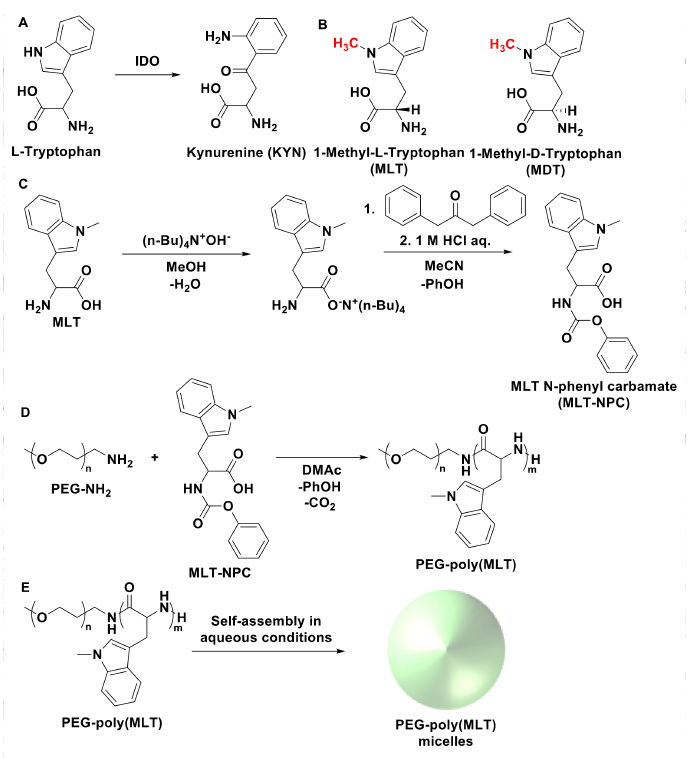
Figure 1. ( A ) Indoleamine 2,3-dioxygenase (IDO) catabolizes L-tryptophan into Kynurenine, leading to immunosuppression. ( B ) Two IDO inhibitor homologs, 1-Methyl- l -Tryptophan (MLT) and 1-Methyl- d -Tryptophan (MDT; Indoximod). ( C ) Synthesis scheme of MLT-N-phenyl carbamate (NPC). ( D ) Ring opening polymerization of MLT-NPC with polyethylene glycol initiator. ( E ) Self-assembly of block copolymer into micelle in aqueous